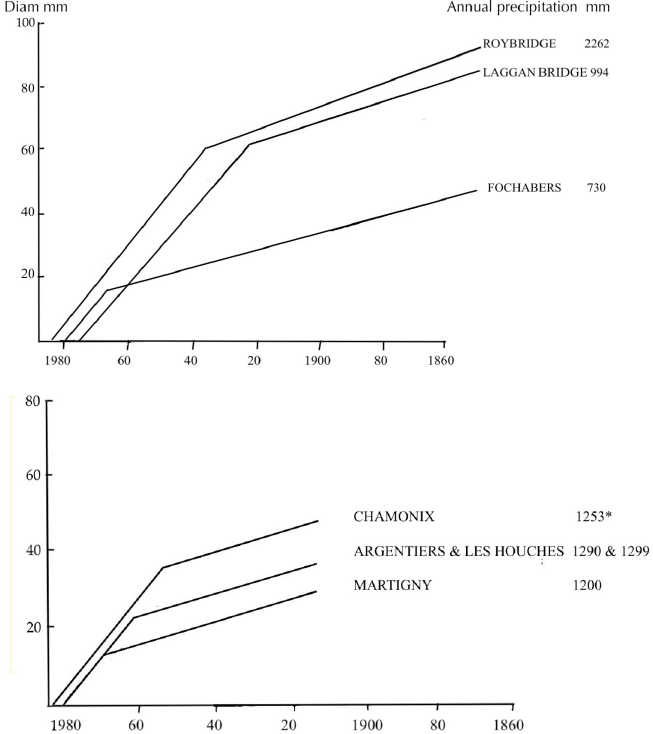
Figure 2. The effect of moisture differences at different latitudes on the growth of section R. geographicum, with rainfall varying wet to dry, across Scotland and the western Alps. The Chamonix curve (*) is inflated probably due to the site being on an alluvial fan (see Figure 3) [15].